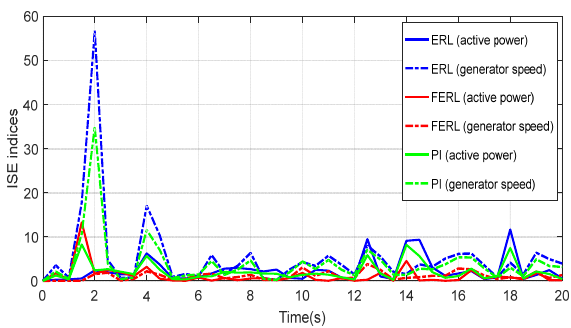
Figure 12. Integral square error (ISE) indices in different time periods.